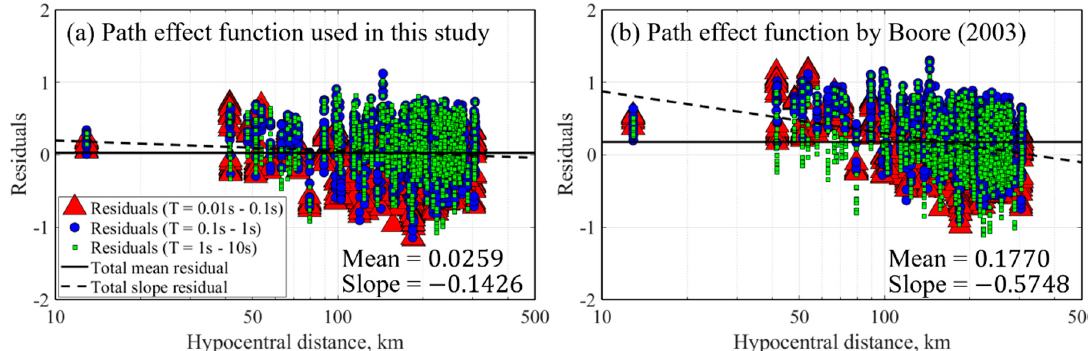
Figure 13. Estimated residuals, mean residual, and slope residual at various periods for the 2017 Pohang earthquake: (a) Path effect function used in this study, (b) Path effect function by Boore